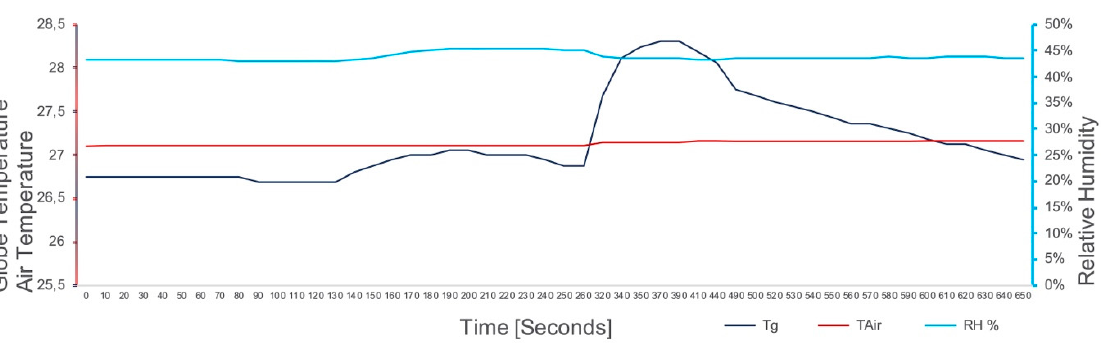
8 of 24 Figure 4. The model’s exterior frame and setting of the components. 4. Data Acquisition and Handling The sampling of an observed physical phenomena and the conversion of the samples into compatible numerical values for computer analysis is called data acquisition. The real-world conditions are measured with fluctuations in electrical signals of certain material in reference to those conditions. By nature, these signals are analog, which is amplified and converted into digital signals. The digital signals are packets of 0 s and 1 s, which are converted into the decimal system by an interpreter. The processed data is stored in the R/W memory of the computer. A simple data acquisition system (DAS) is outlined in Figure 5.